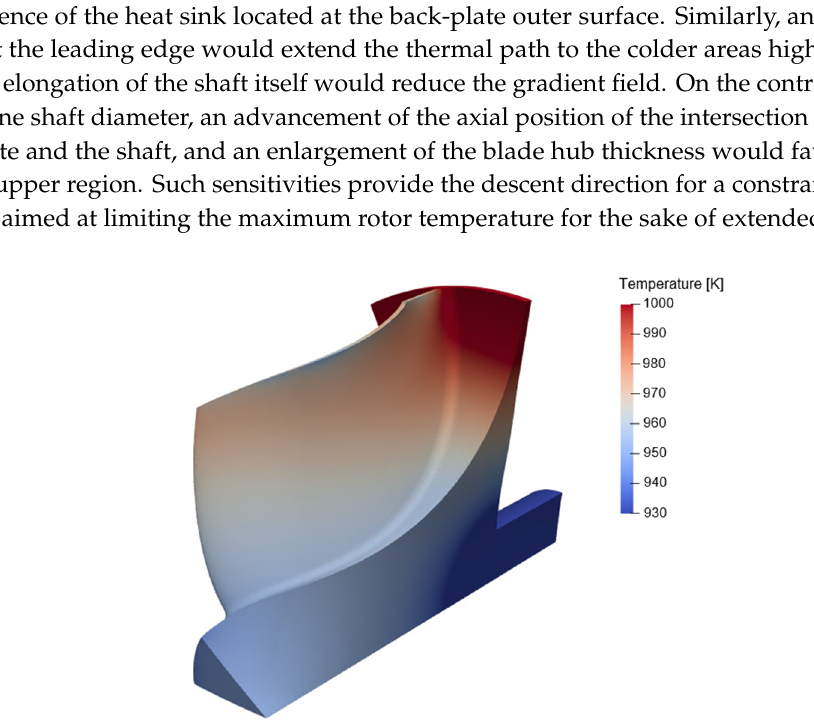
Figure 19. Solid temperature on turbine rotor (operative condition from Table 2).